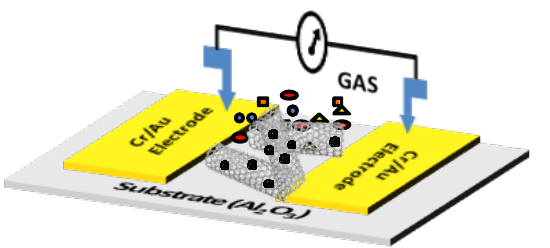
Figure 2. Scheme of Au-modified CNTs-based gas sensor device.